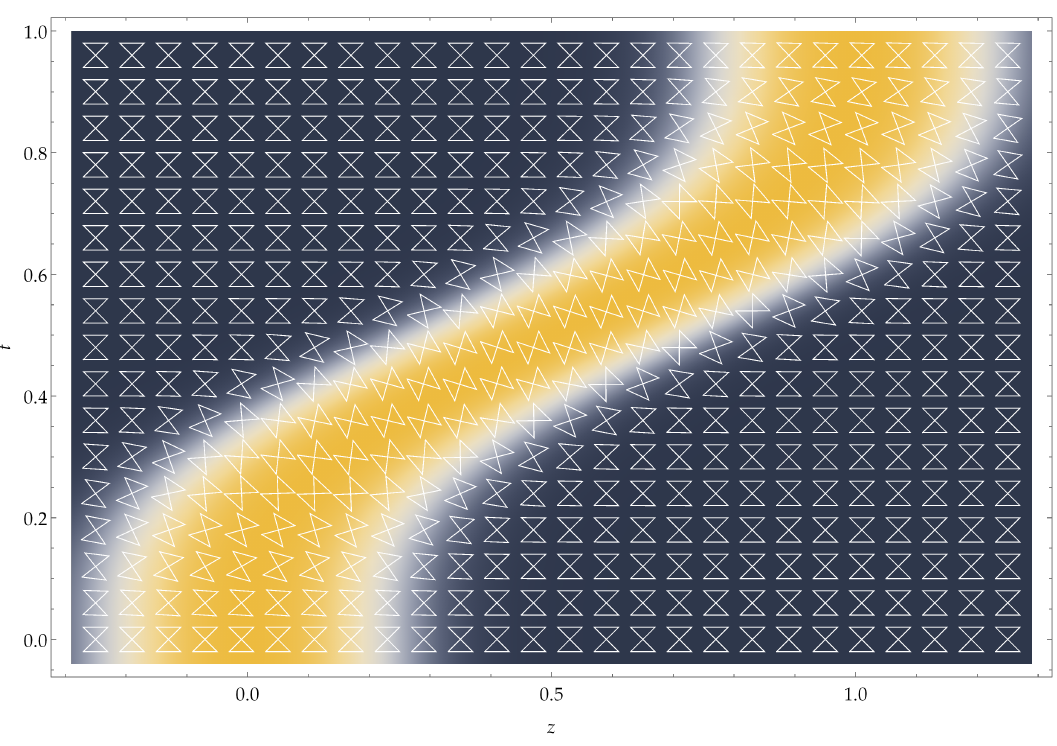
Figure 3: A spacetime diagram for a warp bubble (in yellow) with R = 0.25, (cid:34) = 0.1, and v ( t ) = 2sin 2 ( π t ) . It starts at rest at t = 0, accelerates up to a maximum velocity of v = 2 at t = 0.5, and then decelerates to rest at t = 1. The light cones have slopes ± 1 + v f , so when v > 0 they are “tipped over” inside the bubble such that the spaceship locally remains within its own light cone at all